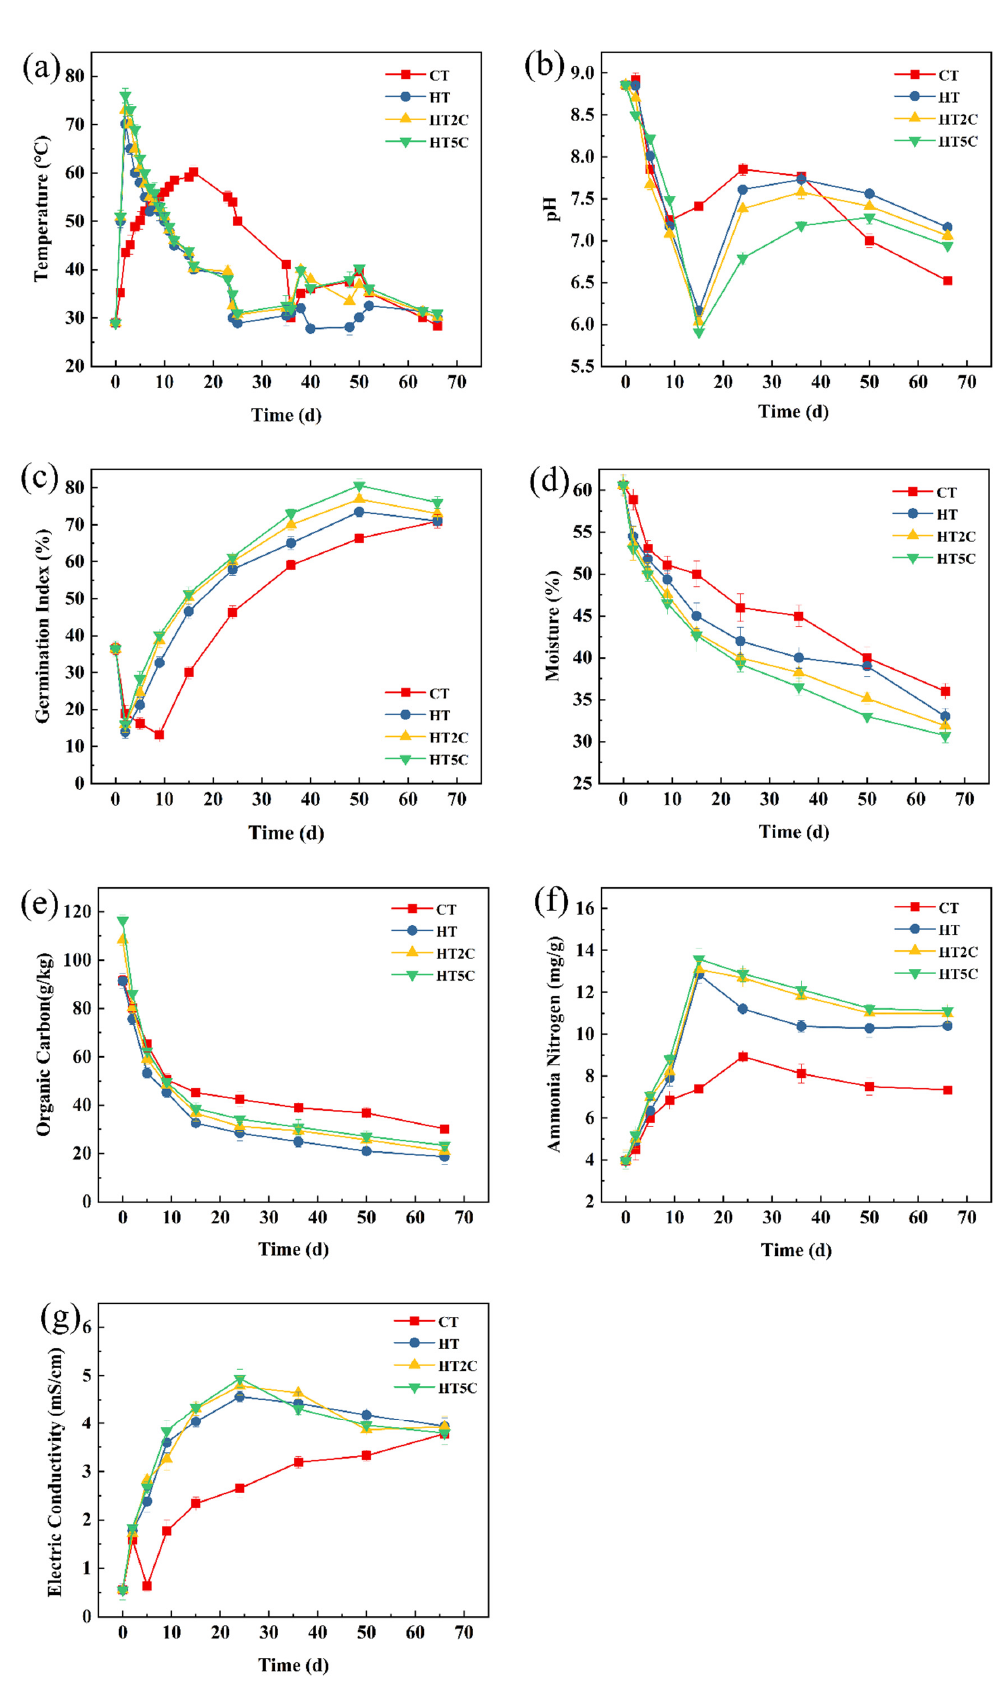
Figure 1. Physicochemical properties of composting: ( a ) temperature, ( b ) pH, ( c ) germination index (GI), ( d ) moisture, ( e ) organic carbon, ( f ) ammonia nitrogen and ( g ) electrical conductivity